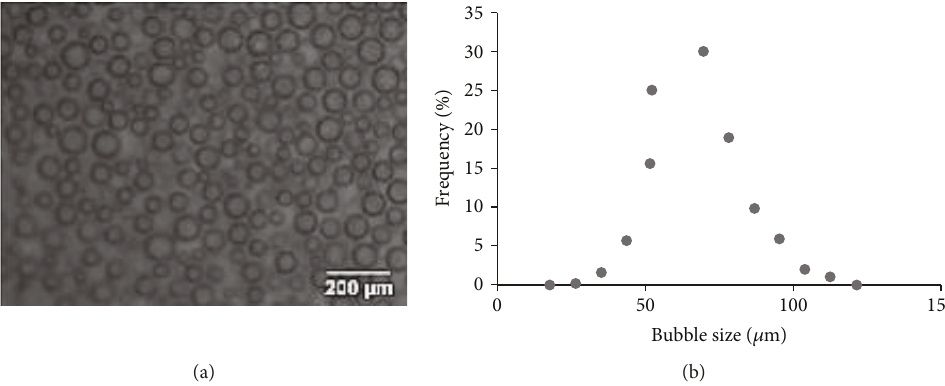
Figure 3: General bubble distribution analysis of fresh foams obtained using NAGU. (a) Microscopic analysis of fresh foam from the CS/WPI/SiO recipe and (b) bubble size distribution of fresh foam from the CS/WPI/SiO 2 detected for all recipes (i.e., CS/WPI, CS/WPI/HAp, and CS/WPI/SiO Table 5: In fl uence of the gas fl ow rate on the properties of liquid foams obtained in the continuous process using NAGU with the formulation CS/WPI/HAp ( L = 30 mL min − 1 , N = 600rpm ).